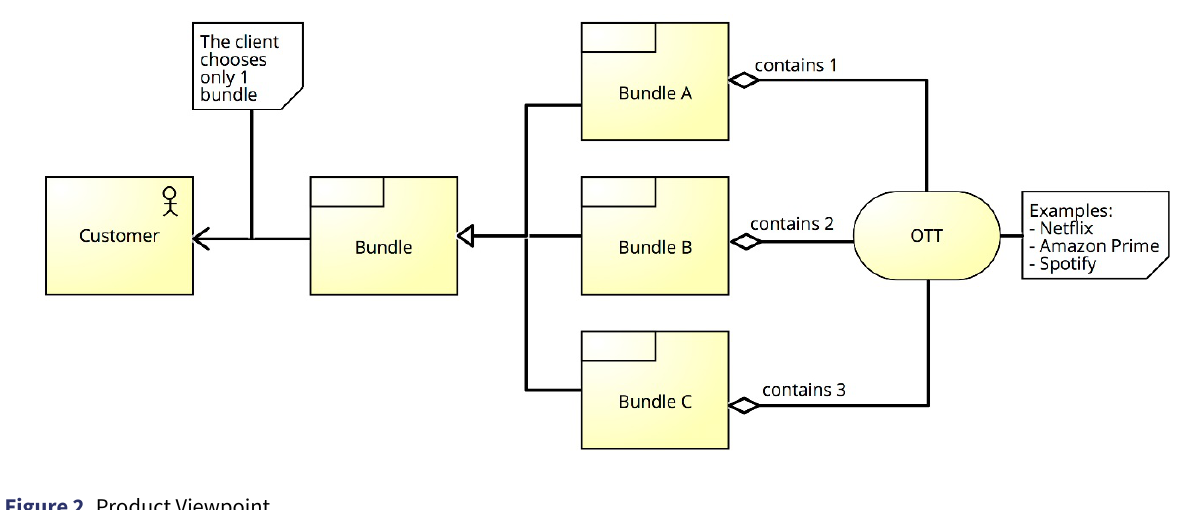
Figure 2. Product